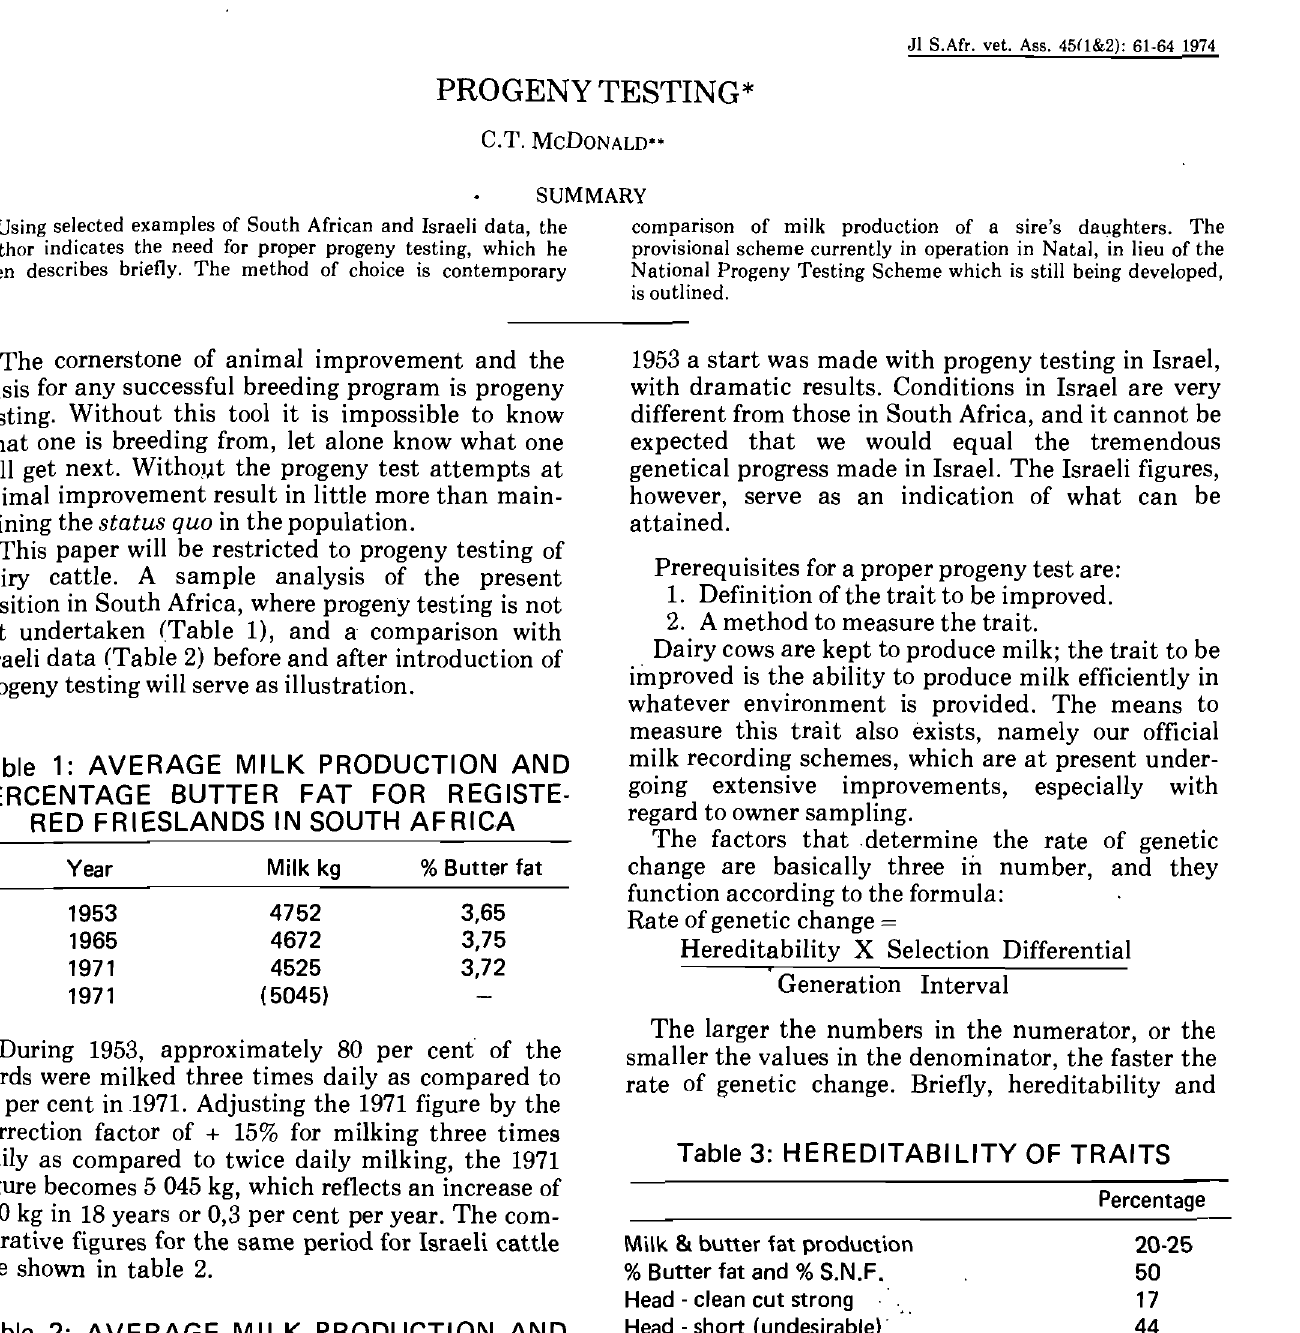
Table 2: AVERAGE MILK PRODUCTION AND PERCENTAGE BUTTER FAT FOR ALL RECOR DED COWS IN ISRAEL